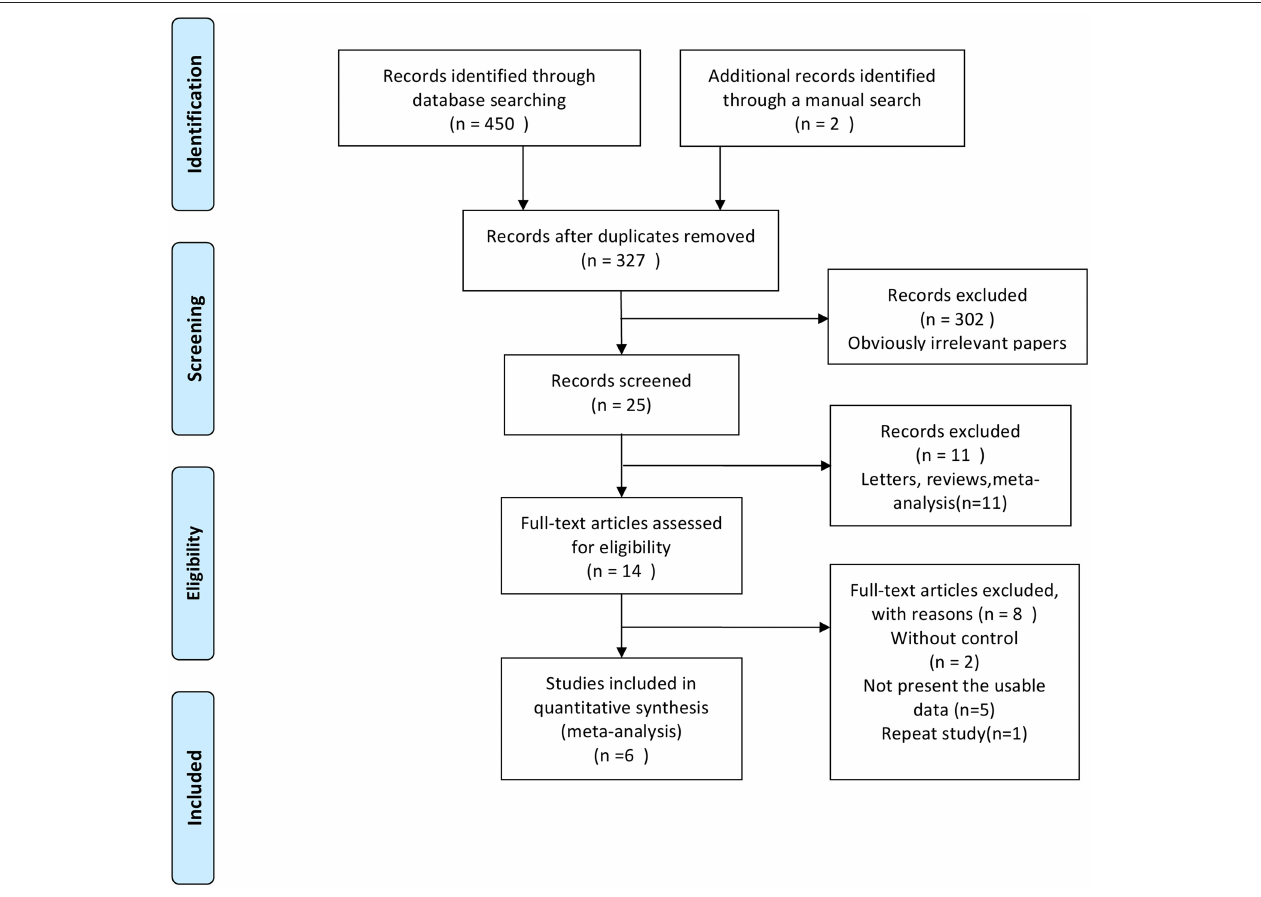
FIGURE 1 | Flow diagram of the study selection